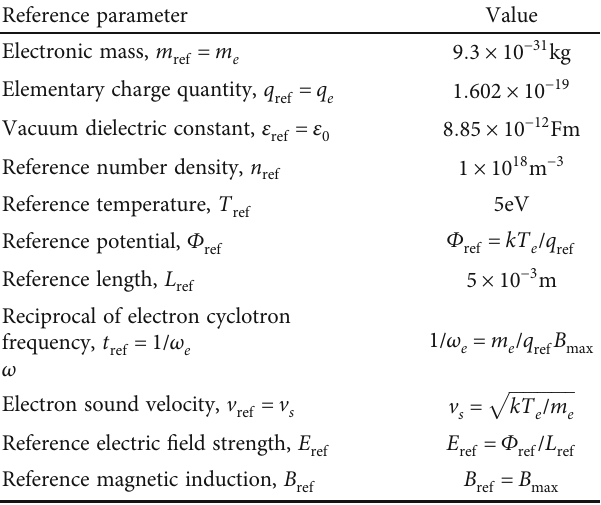
ffiffiffiffiffiffiffiffiffiffiffiffiffiffi p kT